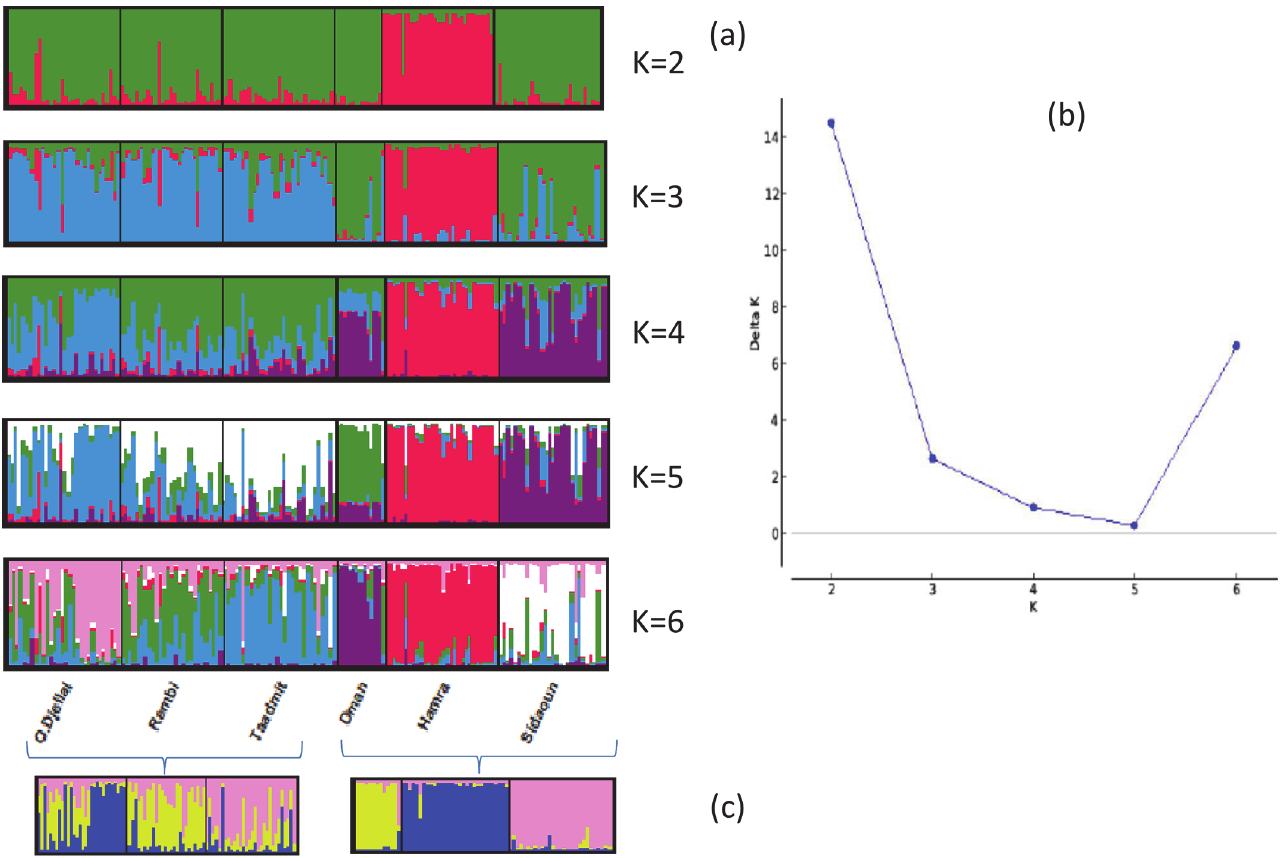
Fig 1. Genetic structure of Algerian sheep breeds by Bayesian analysis with 30 microsatellite loci (K = number of clusters). (a) Analysis on the entire data set with increasing number of inferred clusters (K = 2 to K = 6); (b) Graph showing Δ K calculated according to Evanno et al. [30]; (c) further analysis in the group of “ white breeds ” (Ouled-Djellal, Rembi and Taâdmit) and the group of the three other breeds (D ’ man, Hamra and Sidaoun).